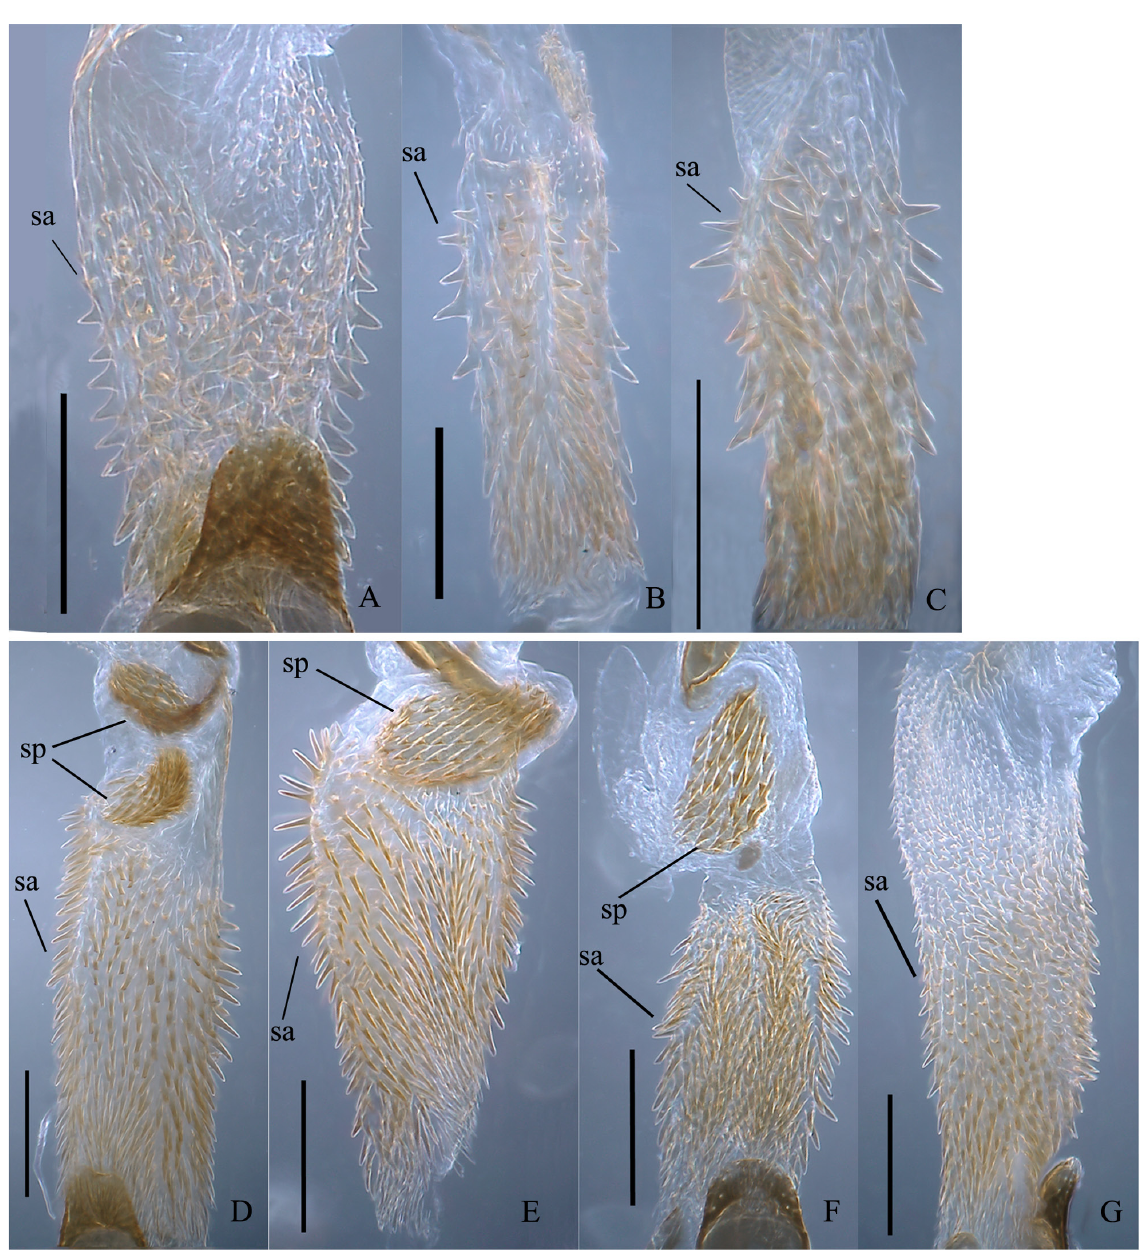
Fig. 9. Spinous area and spinous plate of Intybia spp. A . Intybia histrio (Kiesenwetter, 1874). B . I. tsushimensis (Satô & Ohbayashi, 1968). C . I. donan sp. nov. D . I. pelegrini pelegrini (Pic, 1910). E . I. niponica (Lewis, 1895). F . I. takaraensis (Nakane, 1955). G . I. kishiii (Nakane, 1955). Abbreviations: sa = spinous area; sp = spinous plate. Scales = 0.1